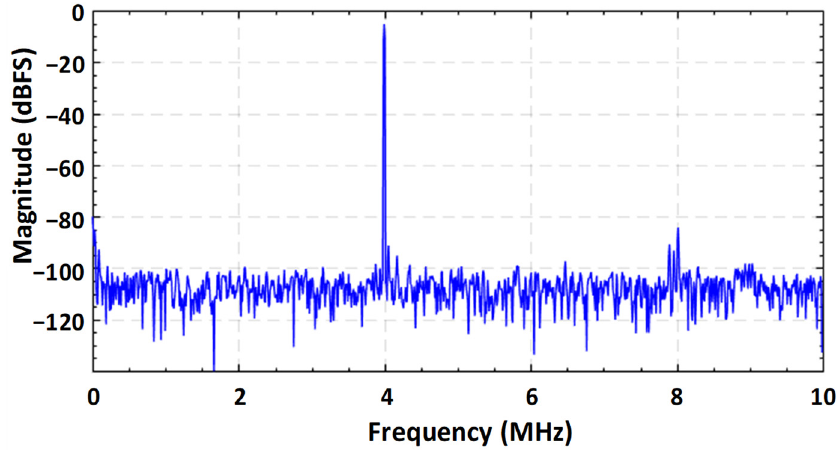
Figure 6. Dynamic performance with behavioral model of proposed switching technique with 1% unit capacitor mismatch.